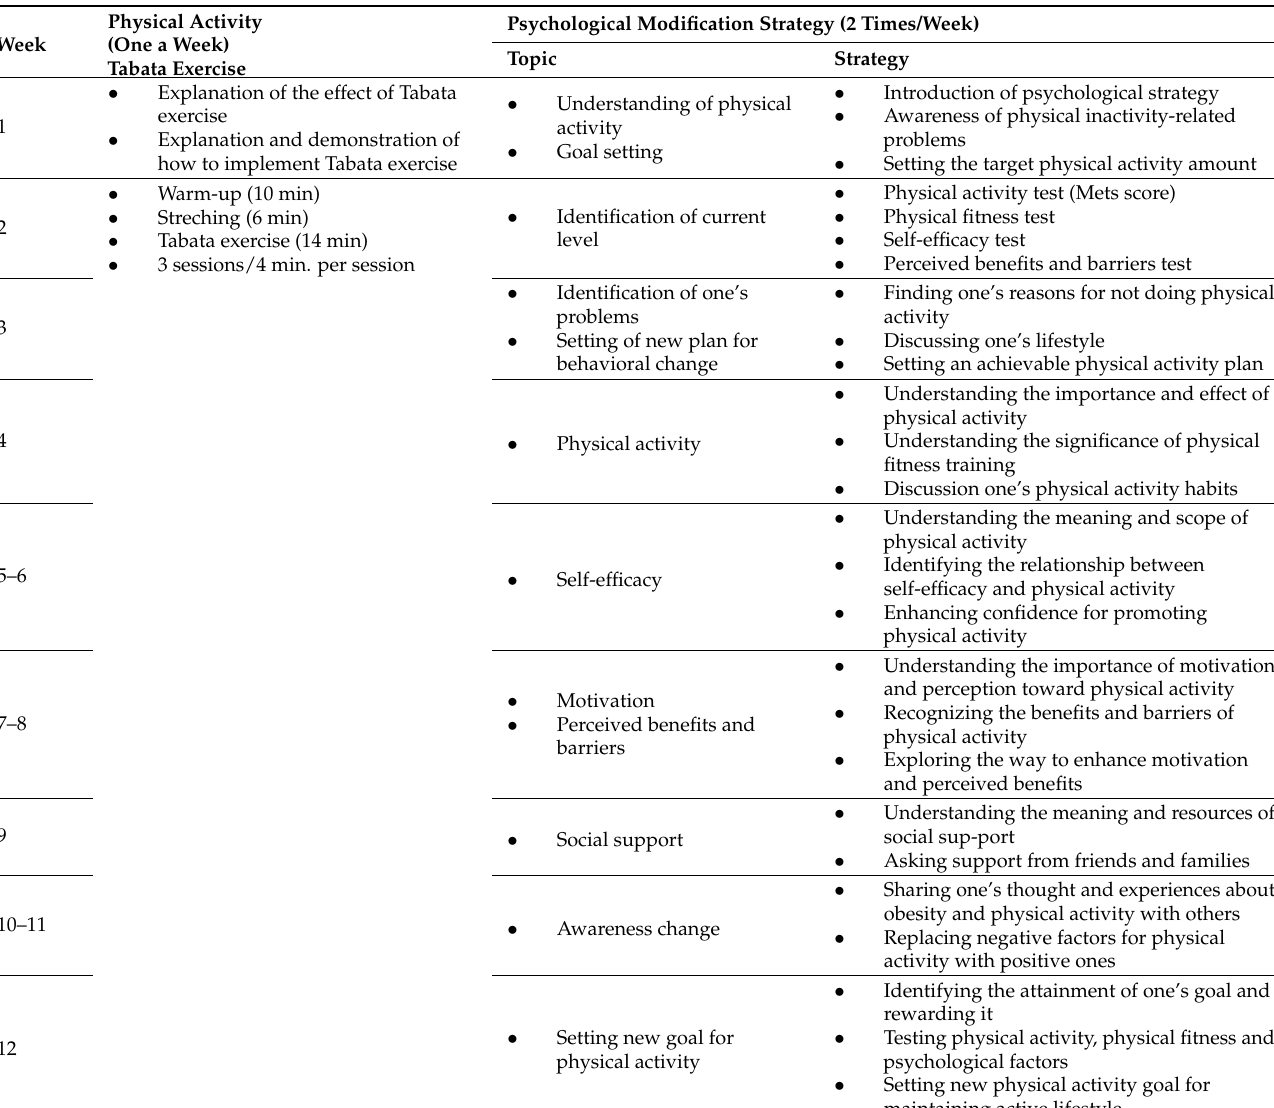
Table 2. Physical activity and psychological modification-based